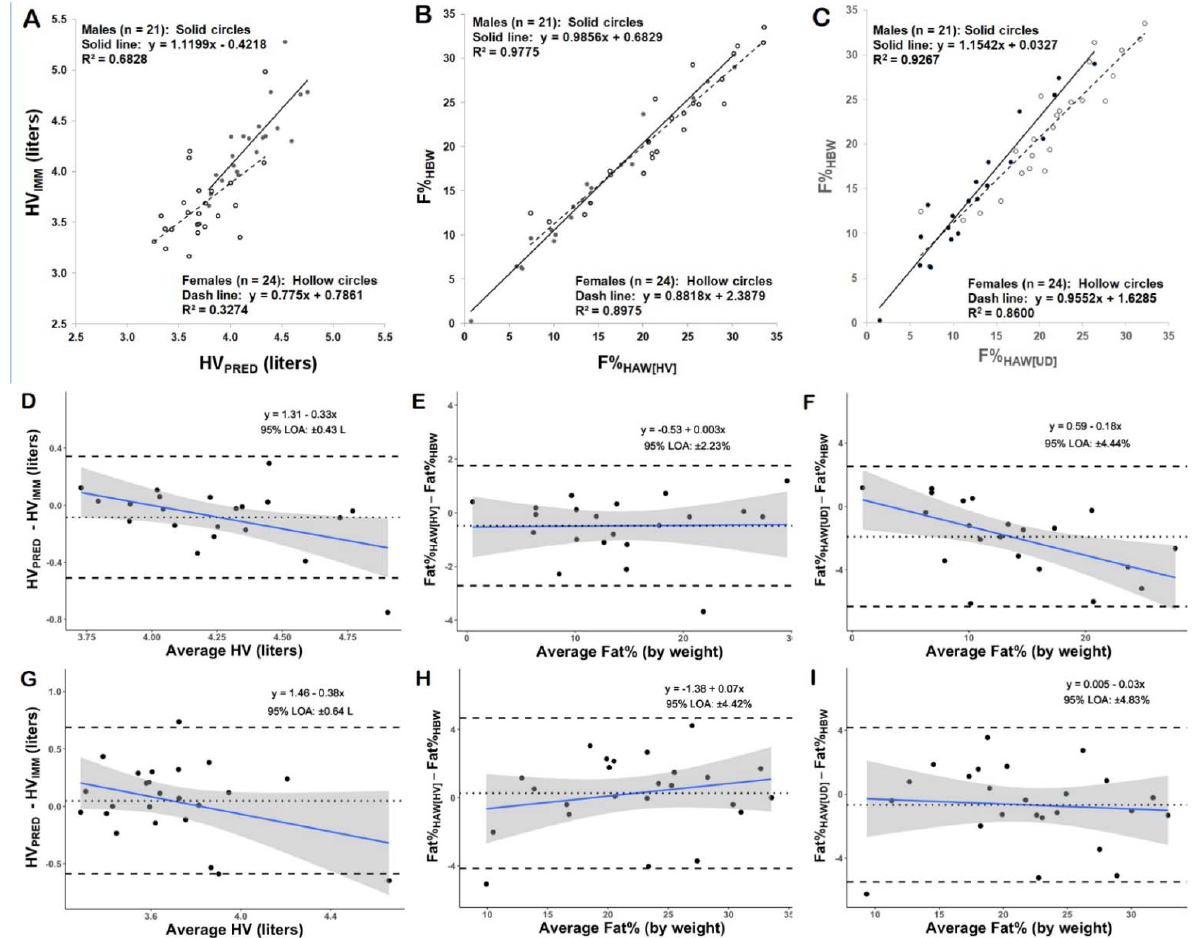
Figure 4. XY and Bland–Altman plots for validation groups. Panels ( A – C ) show XY plots for both males and females: ( A ) predicted head volume (HV PRED ) vs. head volume from immersion (HV IMM ), ( B ) fat% by head above water immersion with predicted head volume (F% HAW[HV] ) vs. fat% by head below water immersion (F% HBW ), and ( C ) fat% by head above water immersion predicted from uncorrected density (F% HAW[UD] ) vs. fat% by head below water immersion (F% HBW ). Panels ( D – F ) show Bland–Altman plots for the male subjects’ data corresponding to panels ( A – C ). Panels ( G – I ) show Bland–Altman plots for the female subjects’ data corresponding to panels ( A – C ). The solid sloping lines in the Bland–Altman plots are the linear regression lines representing the relationship between the difference between the predicted and criterion values vs. the average of the predicted and criterion values. The shaded regions in the Bland–Altman plots indicate the 95% confidence intervals along the linear regression lines. The horizontal dotted lines indicate the mean of the difference (constant error or mean bias) between methods. The horizontal dashed lines indicate the upper and lower 95% limits of agreement ( ± 1.96SD). The slope of the regression lines in Bland–Altman plots ( E , G – I ) did not differ from zero ( p > 0.05), indicating no proportional bias. The slope of the regression lines in plots D and F differed significantly from zero ( p < 0.05), indicating proportional